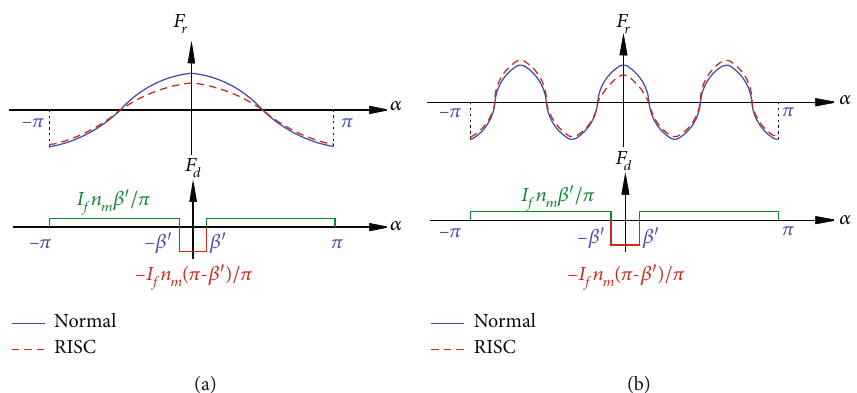
Figure 2: Inverse MMF (only the 1 st harmonic of the normal MMF is considered): (a) QFSN-600-2YHG turbine generator ( p = 1 ) and (b) MJF-30-6 prototype generator ( p = 3 ).